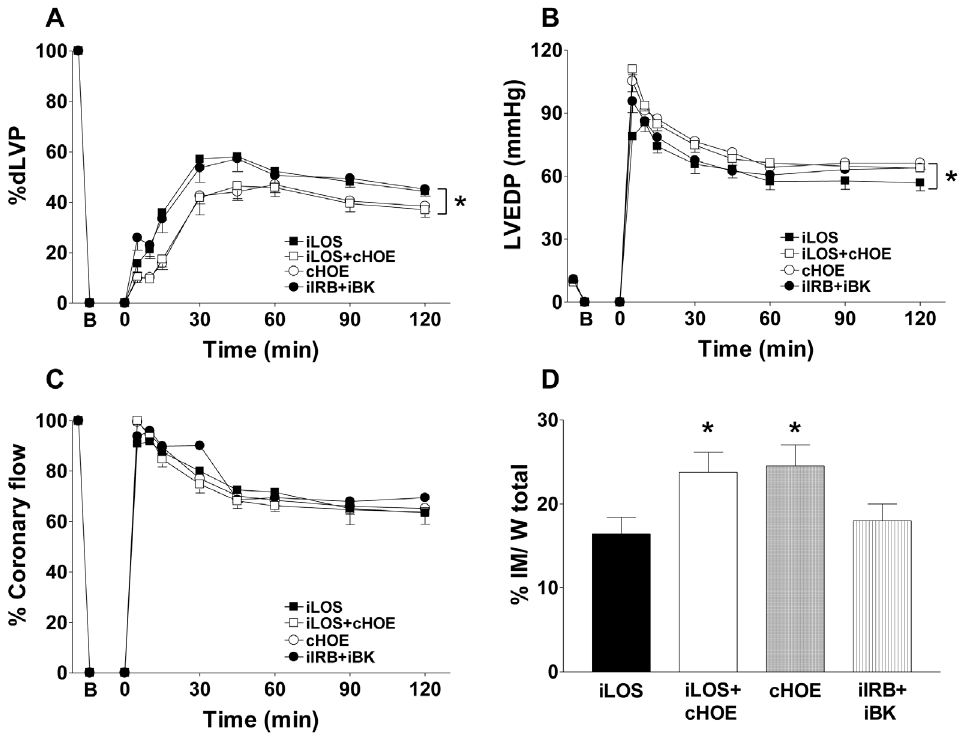
Figure 4. Intermittent losartan post-conditioning is related to modulation of BK system. Hearts exposed to intermittent losartan administration (iLOS group) were compared to hearts exposed to continuous blockade of BK2R with HOE-140 (cHOE group), intermittent losartan under continuous HOE-140 (iLOS + cHOE group) or intermittent administration with both irbesartan and bradykinin (iIRB + iBK group). In each panel, B corresponds to the beginning of ischemia and time 0 corresponds to the beginning of reperfusion. A. Systolic function. Percent variation of developed left ventricular pressure (dLVP) with respect to baseline level for each group, during the 120 min reperfusion following 30 min global ischemia. B. Diastolic function. Left ventricular end diastolic pressure (LVEDP, mmHg) during the 120 min reperfusion following 30 min of global ischemia. C. Percent variation of coronary flow during the 120 min reperfusion following 30 min of global ischemia. D. Infarct mass. The amount of necrotic tissue is expressed as a percent of the left ventricle mass. Two-way repeated measures ANOVA was employed to determine the main effect of time, group and time by group interaction. * p , 0.05.